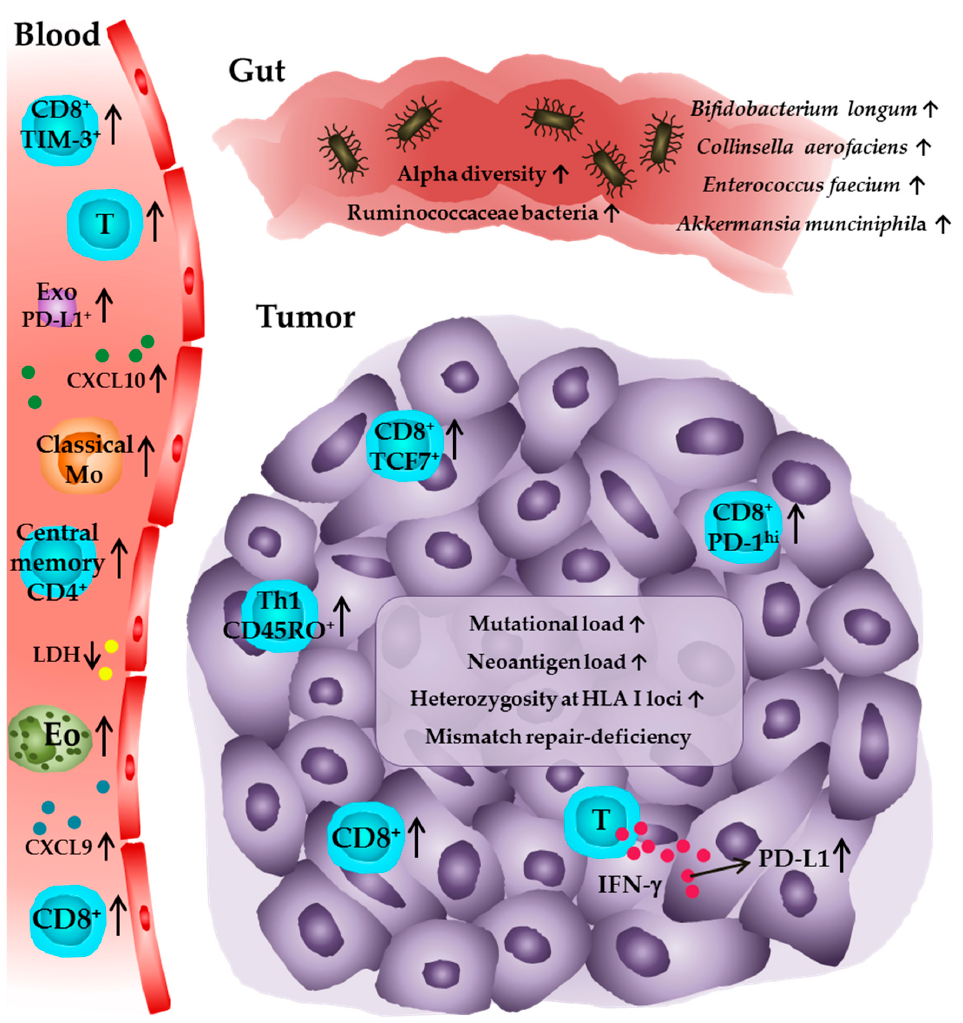
Figure 1. Immune profile of tumor patients receiving anti-PD-1 or anti-PD-L1 antibodies associated with favorable clinical outcome. In peripheral blood, higher numbers of eosinophils, lymphocytes, PD-1 + T cells, TIM-3 + CD8 + T cells, central memory CD4 + T cells, and classical monocytes are